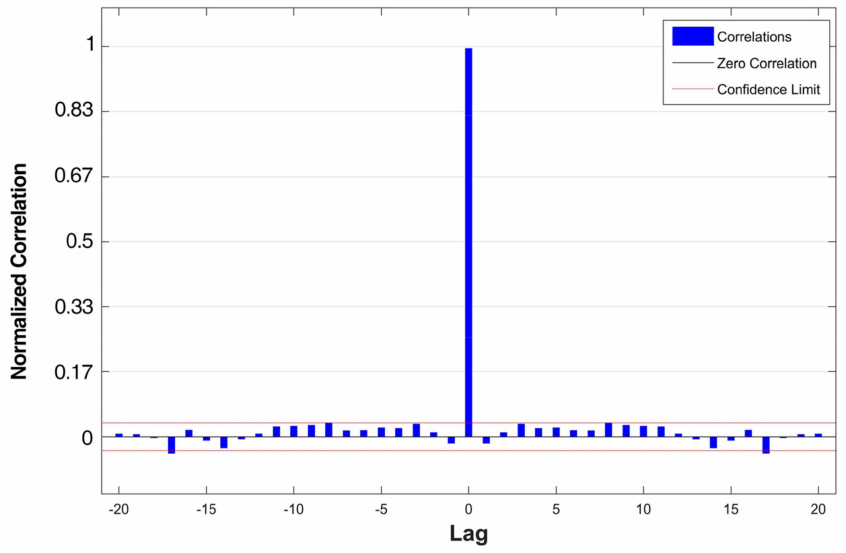
Figure 10. Error autocorrelation of the proposed NARX